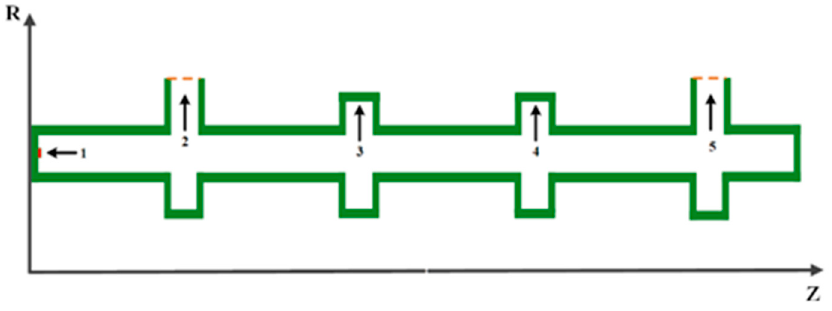
Figure 1. The schematic of a multiple cascaded cavities TKA: 1—cathode, 2—input cavity, 3—second bunching cavity, 4—third bunching cavity, 5—output cavity.